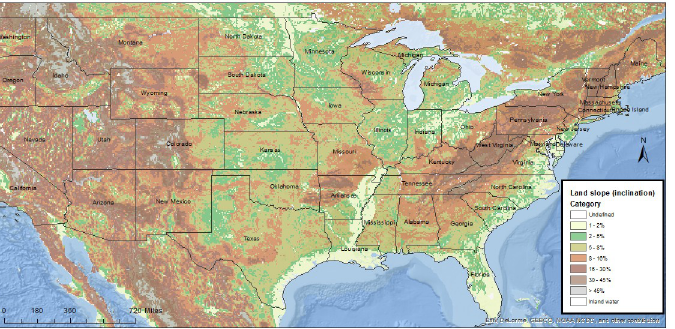
Fig 2. Land slope rastercreated using ArcMap 10.2.2. Data used for the creation of this map was obtained from the “Derived soil properties”of the FAO-NESCO Soil Map of the world, which aggregatesthe GTOPO30 dataset with a spatial resolution of 5 * 5 arc minutes (approximately 10km grids). Information on data processingand equations is available under the “Global Terrain Slope and Aspect Data” reference on the FAO website provided under the reference list [15].